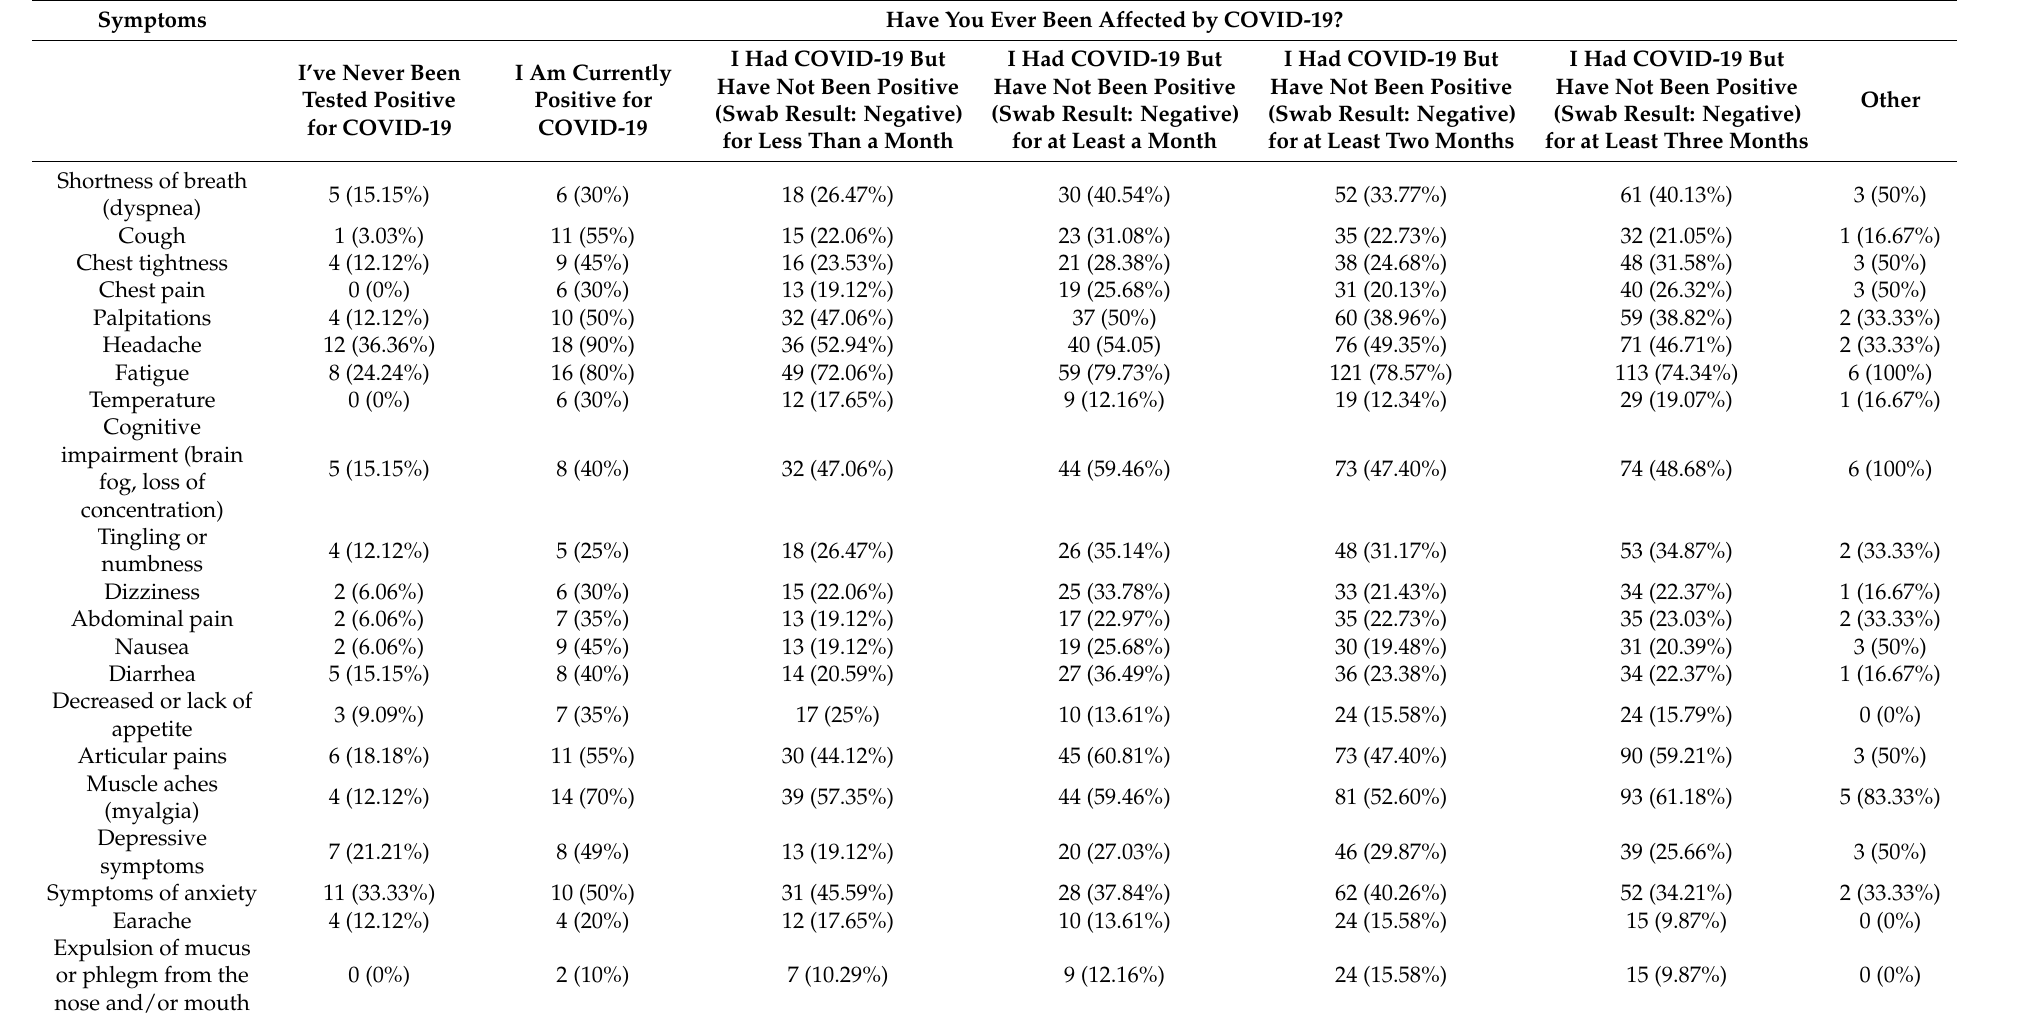
Table 2. Number (N) and percentages (%) of the subjects who indicated a set of symptoms, stratified by COVID-19 positivity